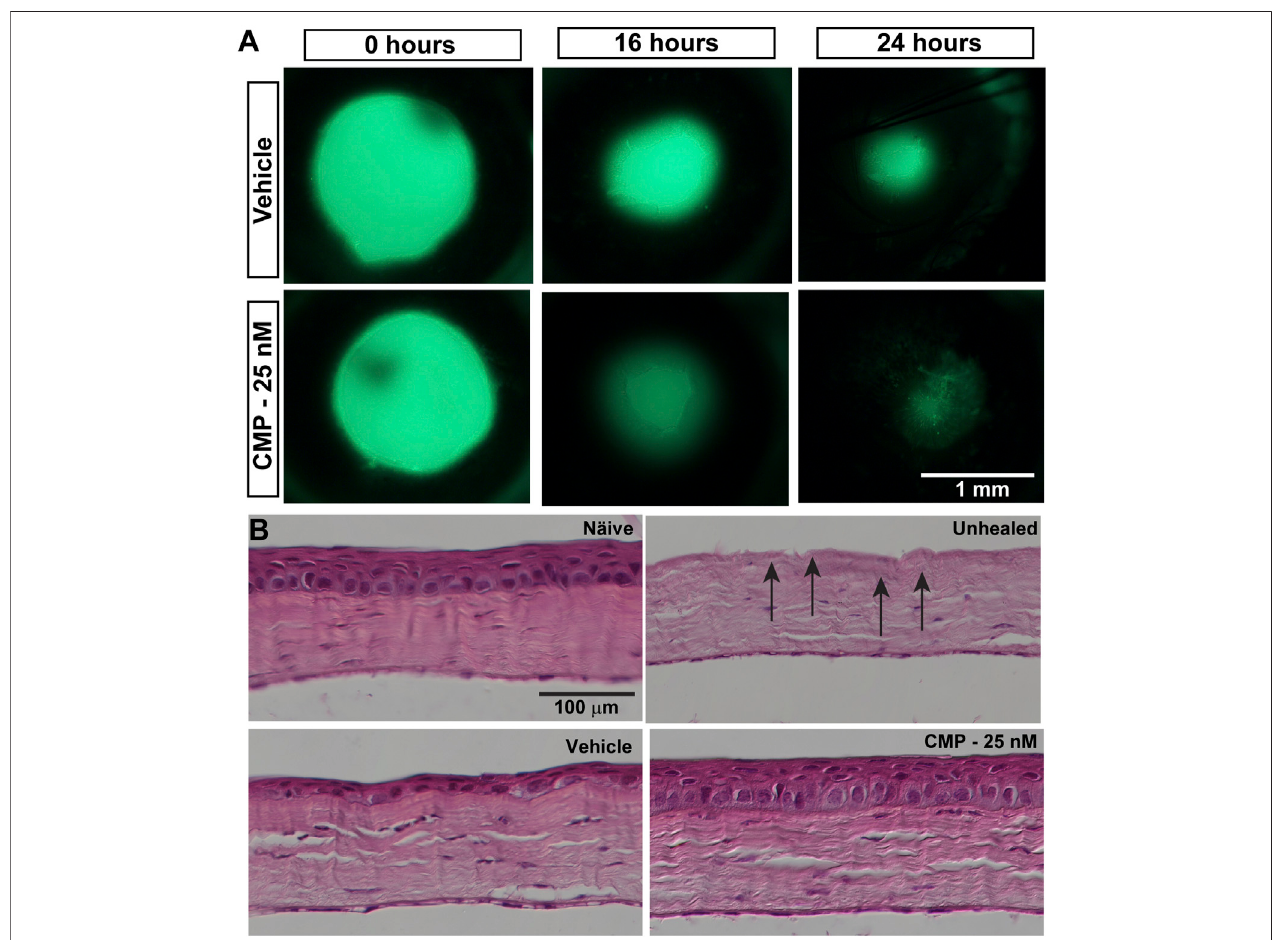
FIGURE 2 | CMP promotes healing of corneal epithelium in mice. (A) Representative images showing residual corneal epithelial wounds visualized by fl uorescein staining in vivo at thetime ofthe initial wound (0 h)and 16and 24 h later. Treatment withCMP (25 nM shown)appearedto accelerate the regenerationofthe epithelium, as seen by smaller wound areas at 16 and 24 h. (B) Representative differential interference contrast images of H&E-stained histological sections through naïve and wounded cornea either left unhealed (by immediate sacri fi ce, arrows) or treated with either a vehicle or CMP and sacri fi ced 24 h later.